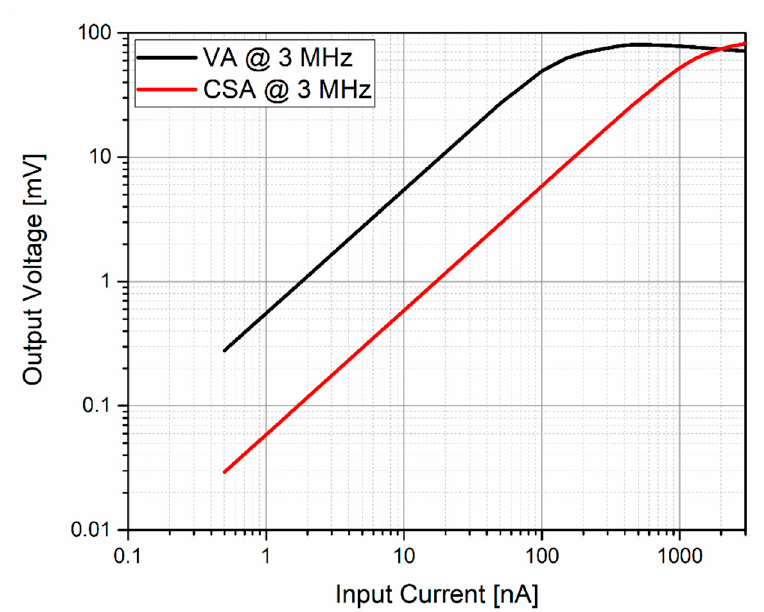
Figure 11. Simulated dynamic range at 3 MHz.